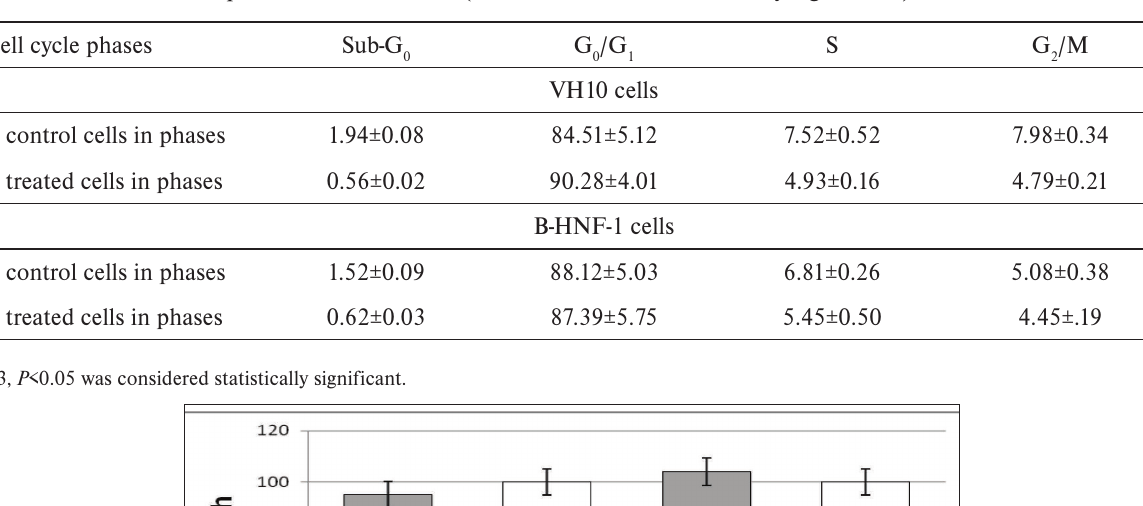
Table 1. Percentage values of cells in subG0, G0/G1, S and G2/M phases determined by flow-cytometric analysis of control (cells without membrane) and treated VH10 and B-HNF-1 cells (cells with membrane). Results are ex- pressed as mean ± SD (the differences are statistically